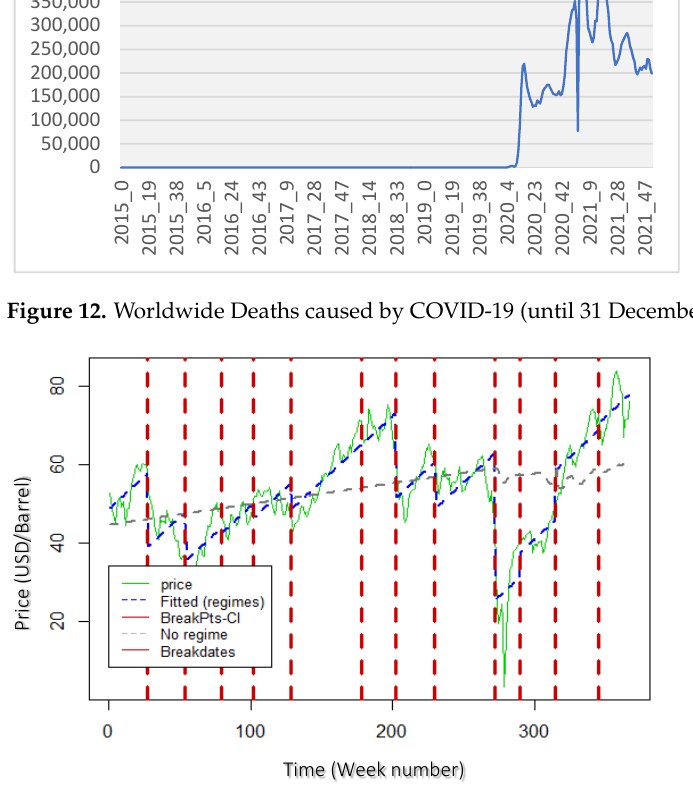
Figure 13. Regime Changes in WTI spot price data (base model with COVID-19 variable).